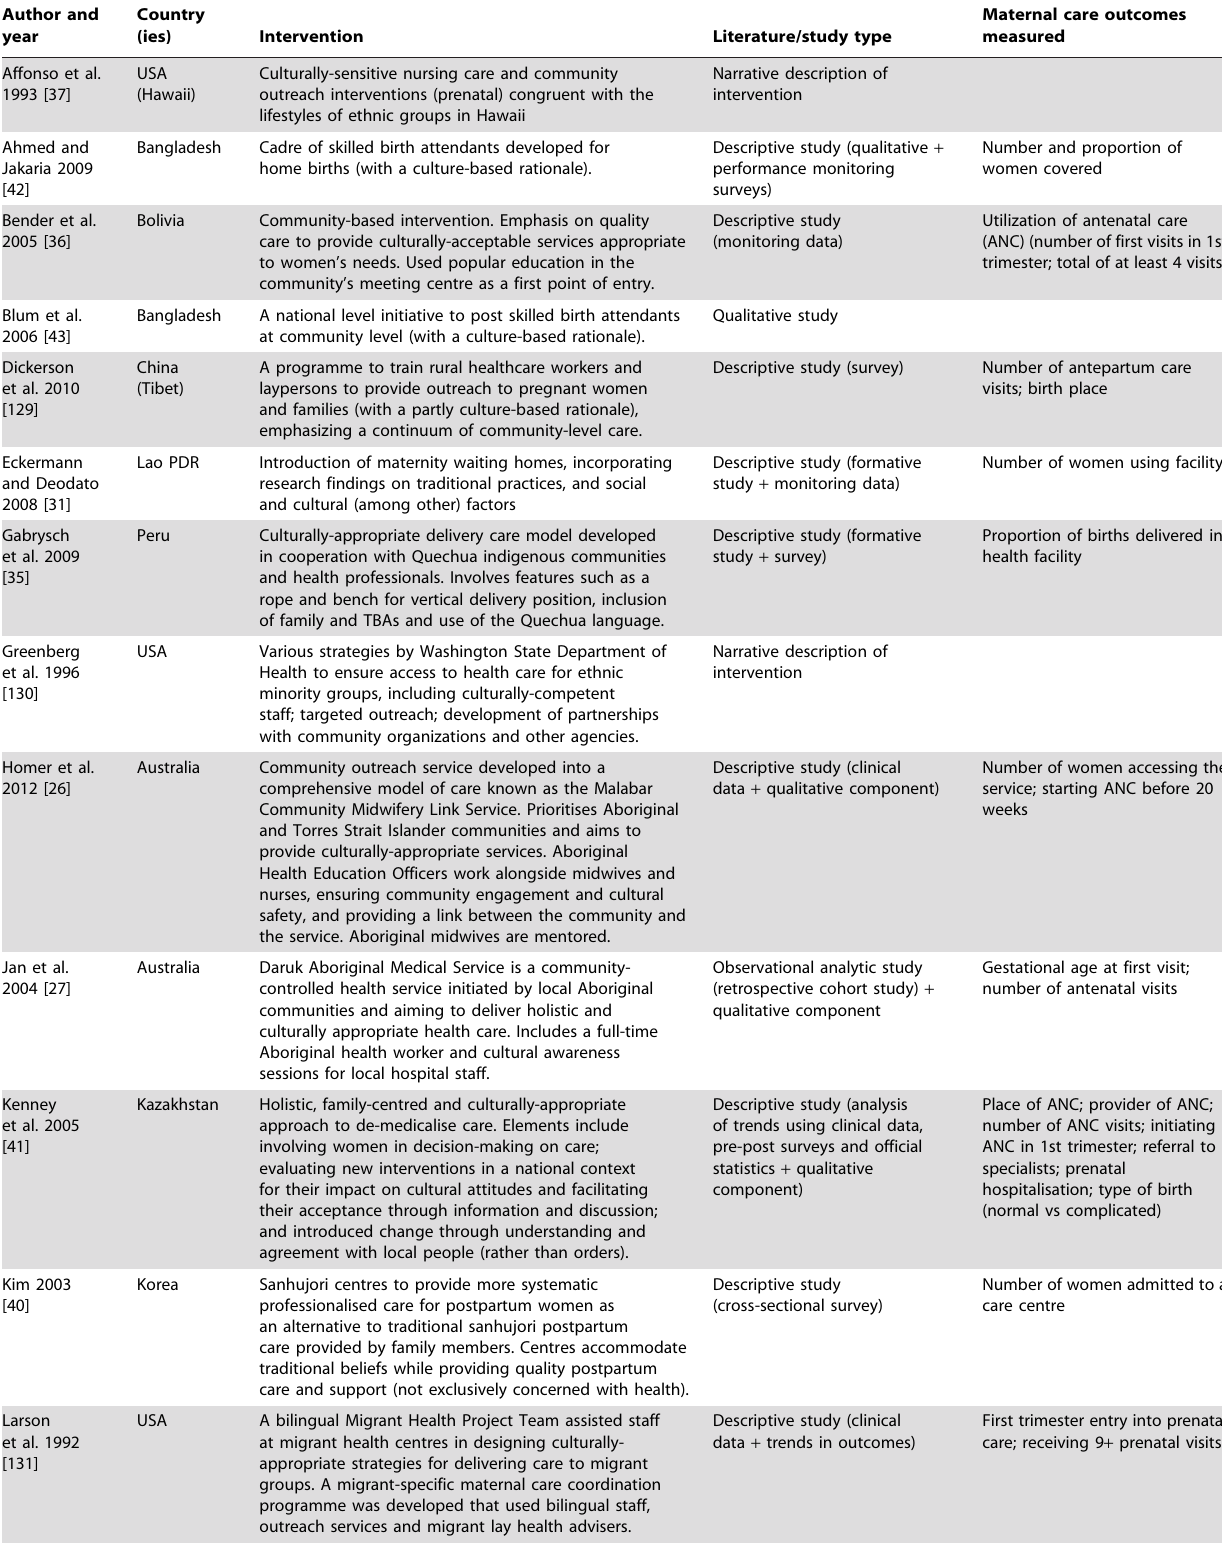
Table 3. Included items: Service delivery